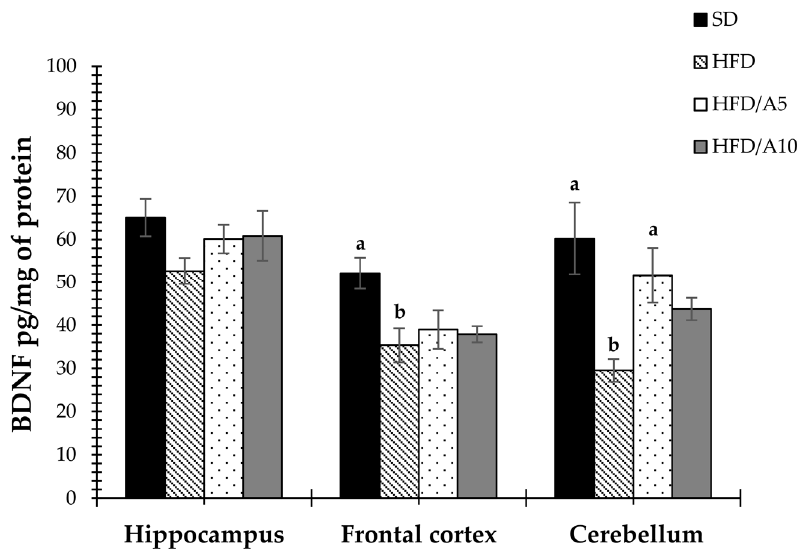
Figure 3. Effects of fructans on brain-derived neurotrophic factor (BDNF) levels in the hippocampus, frontal cortex and cerebellum of mice fed with standard diet (SD); high-fat diet (HFD); high-fat diet with agave fructans 5% (HFD/A5); high-fat diet with agave fructans 10% (HFD/A10). One-way ANOVA and Tukey contrasts were performed to compare differences among groups. The data are represented as the mean with their standard errors of the mean (SEM). N = 10. Mean values with unlike letters (a,b) were significantly different ( p < 0.05).